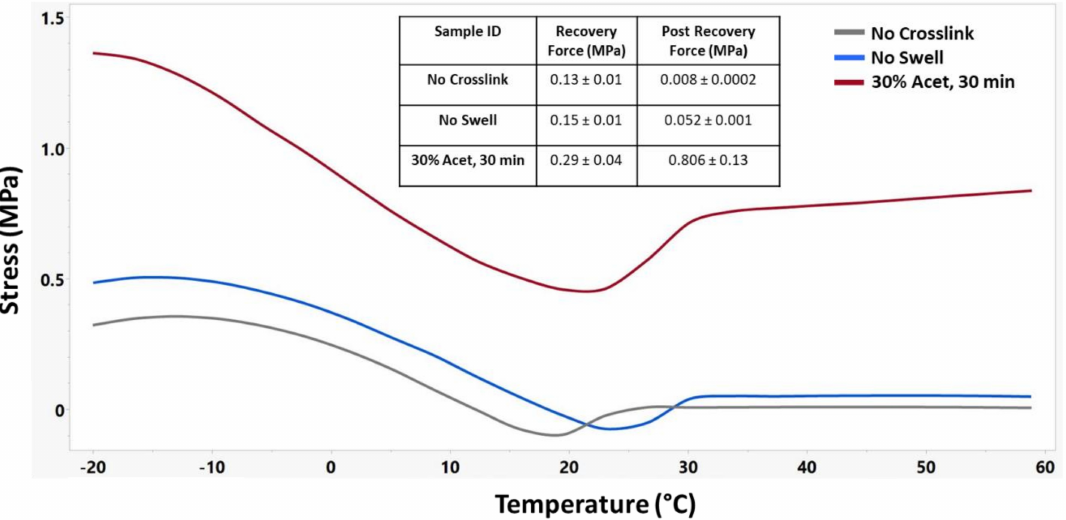
Figure 9. Representative shape recovery force curves of different crosslinking treatments along with corresponding recovery force and post recovery force. n = 3 for each sample group.